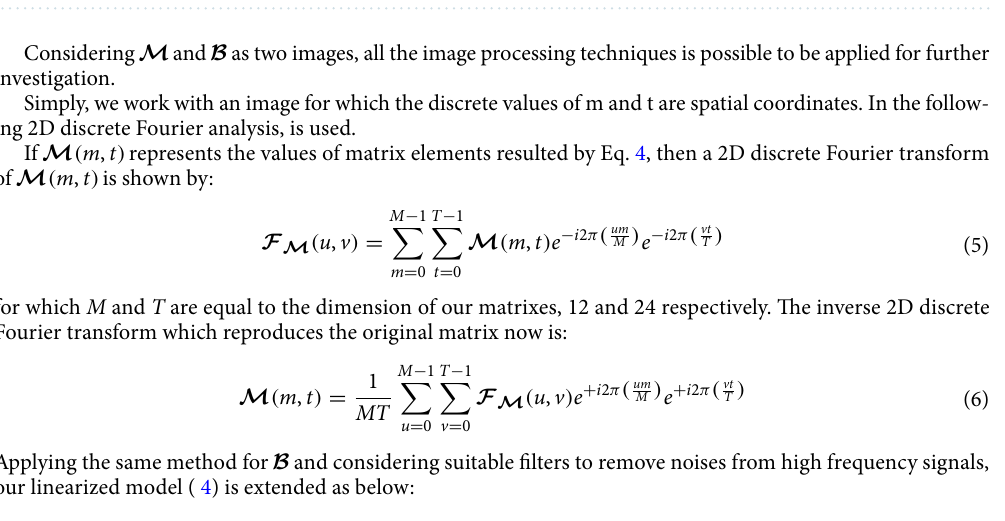
Figure 9. Contour diagram of the Monthly mean GPS-TEC normalized at F10.7 = 100 SFU for various months at different local times during the ascending phase (left panel) and the descending phase (right panel) of the solar cycle 24. The colour scale on the right indicates the different levels of